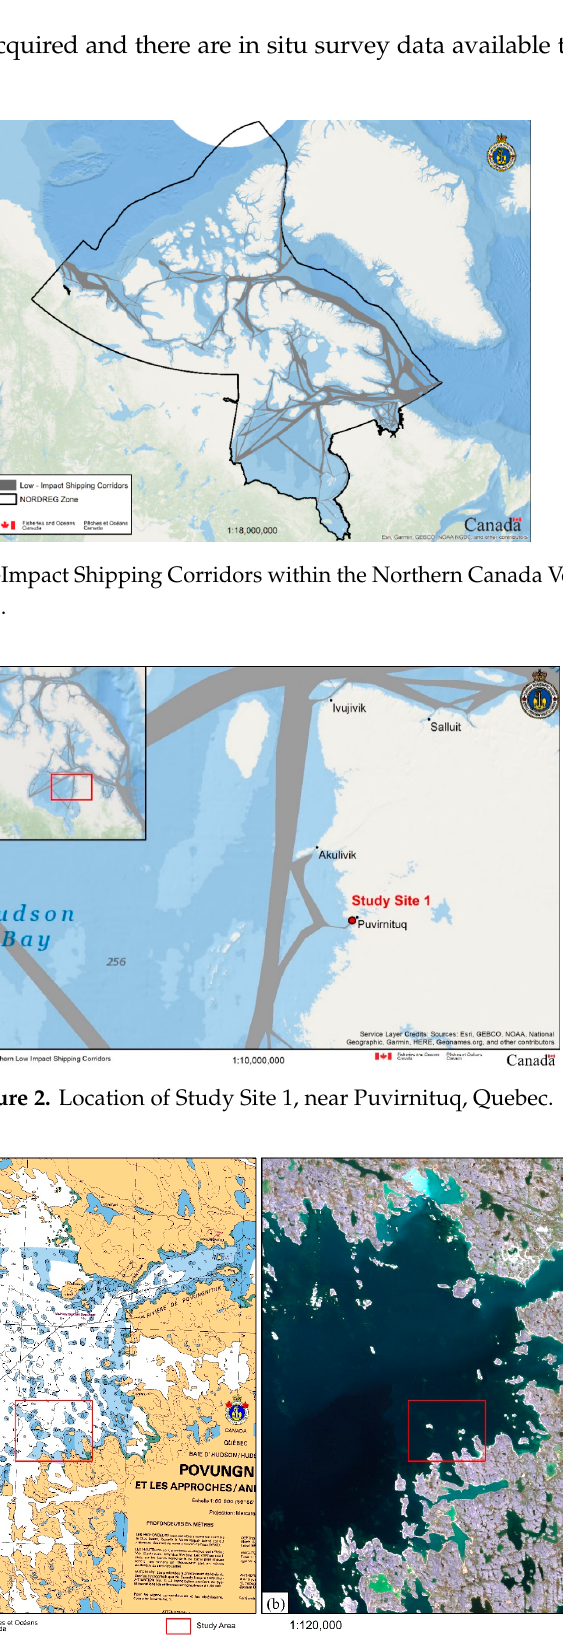
Figure 3. Outline of Study Site 1 in ( a ) Chart 5510 which indicates a large portion of the area is uncharted (showcased through whitespace on the chart), and ( b ) a Sentinel-2 image acquired on 21 August 2019 where shallow water is visible within the study area. © 2019,